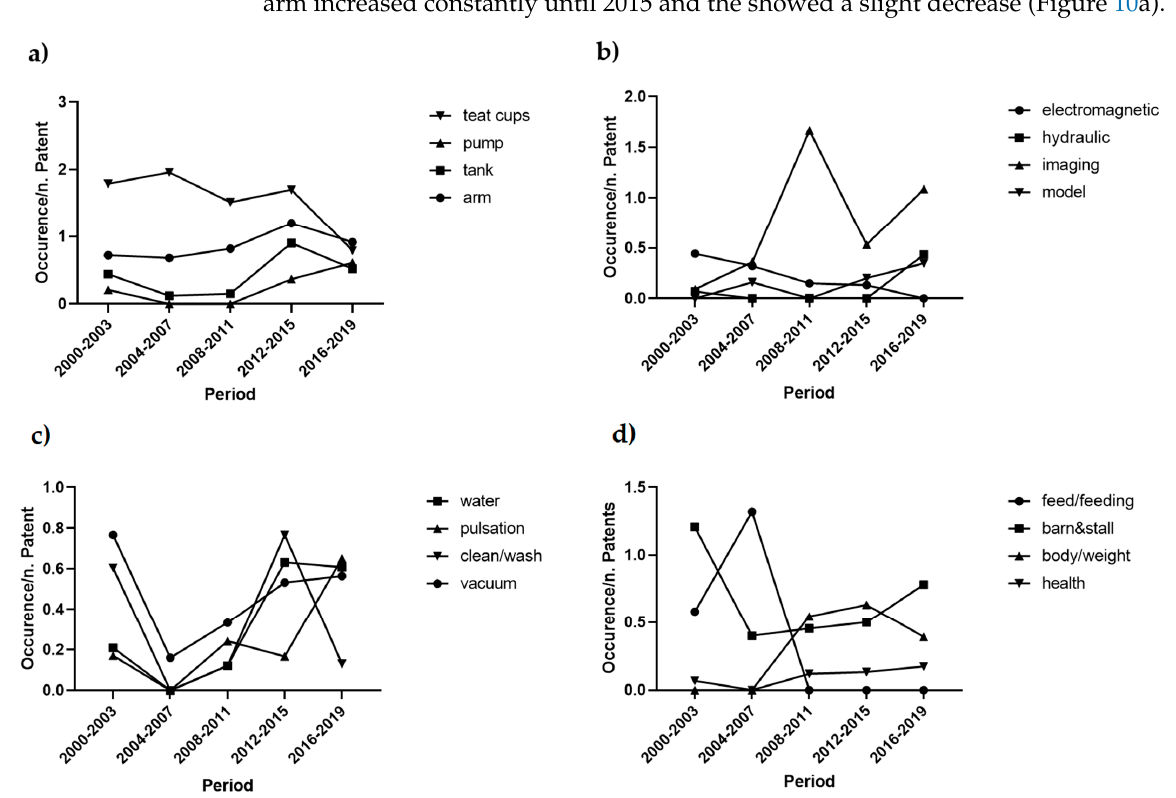
Figure 10. Patents: course of the most representative topics of ( a ) cluster “Components”; ( b ) cluster “Technology”; ( c ) cluster “Process” and ( d ) cluster “Animal” from 2000 to 2019.